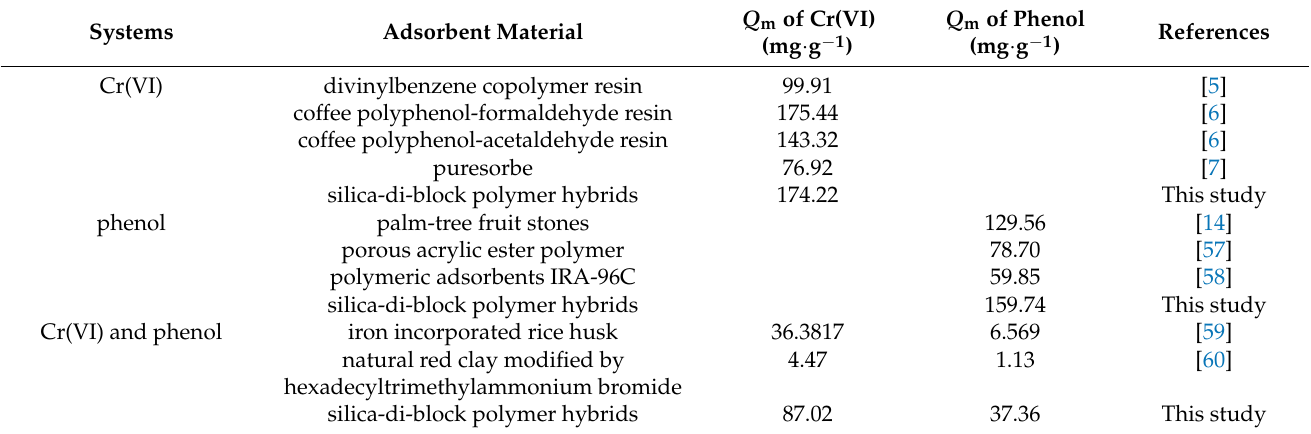
Table 4. Comparison of different adsorbent